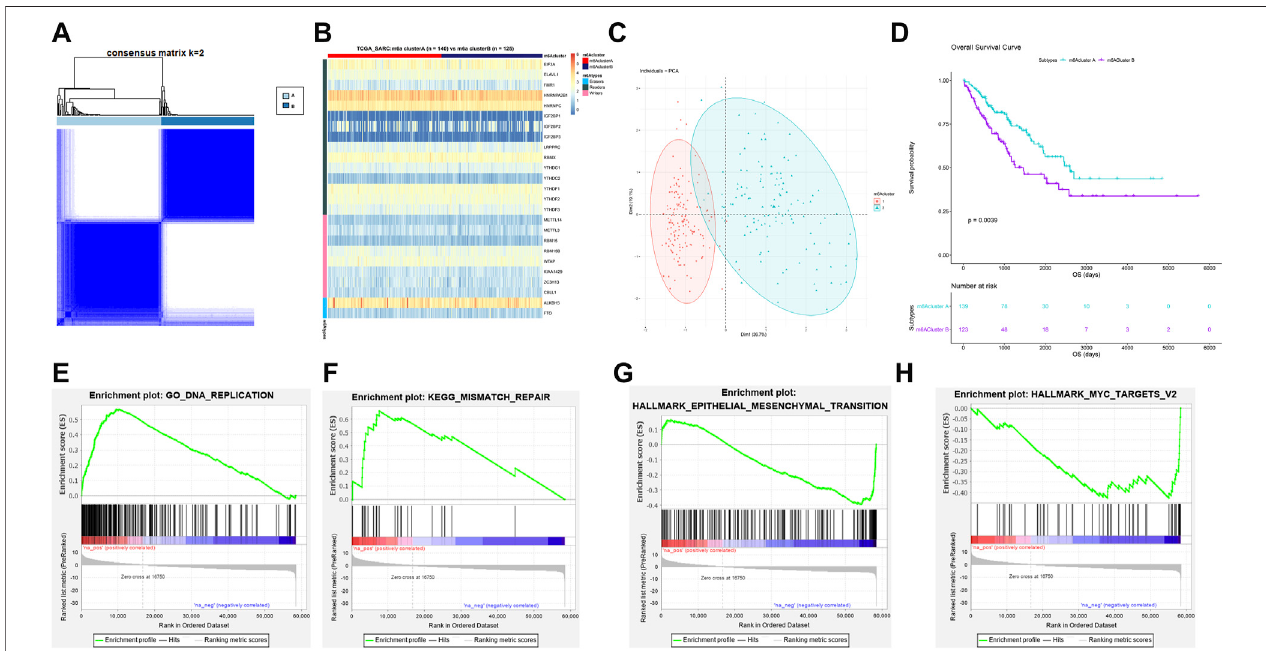
FIGURE 4 | Identi fi cation of two m6A modi fi cation patterns in STS. (A) The result of consensus clustering analysis in STS; (B) heatmap of expression of 25 m6A regulatorsinm6AclustersAand B; (C) theresultofPCA,indicatingtwodistinct clusterswereidenti fi ed; (D) survivalplotoftwoclustersinTCGA-SARC ( p =0.0039); (E) enriched pathways in m6A cluster A: DNA replication; (F) enriched pathways in m6A cluster A: mismatch repair; (G) enriched pathways in m6A cluster B: epithelial – mesenchymal transition; and (H) enriched pathways in m6A cluster B: MYC target.